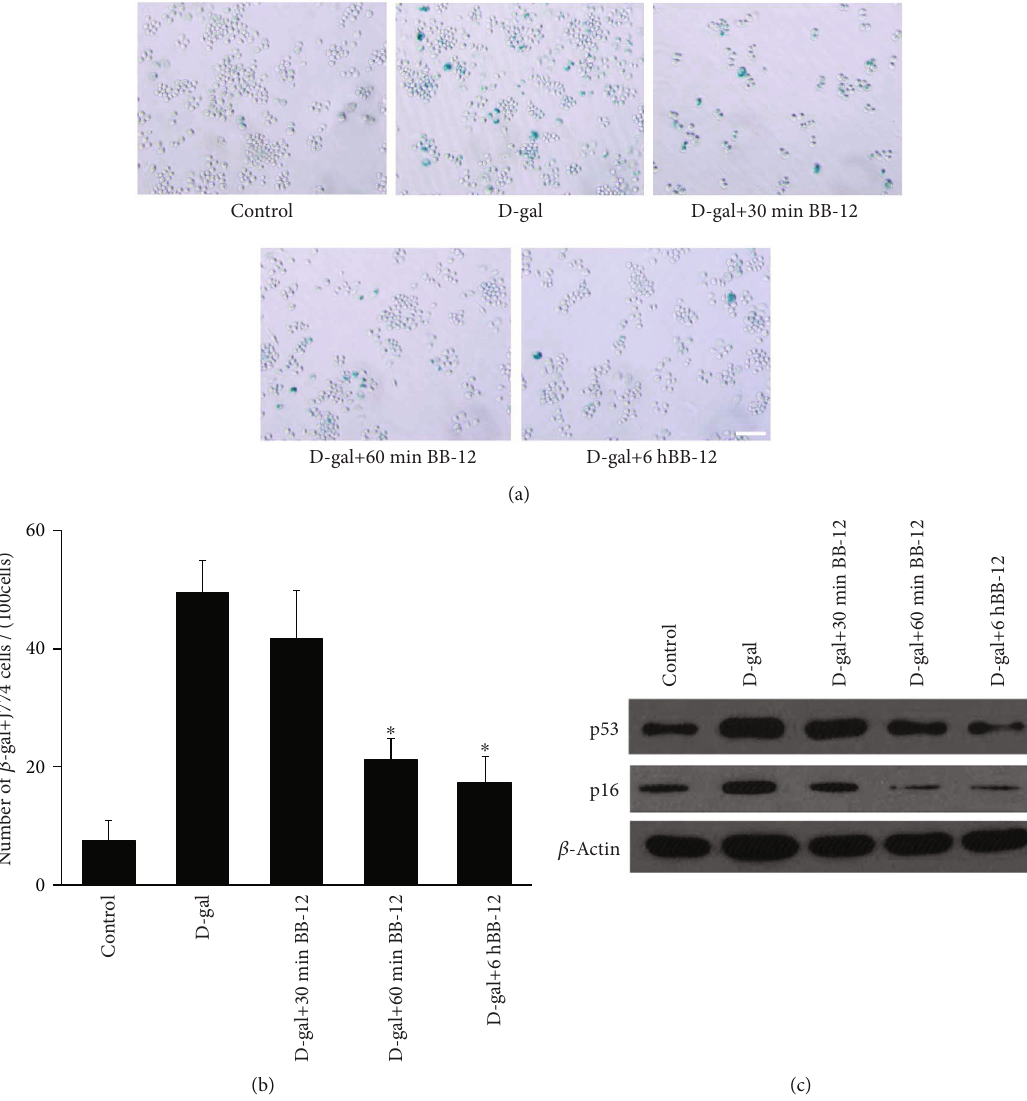
Figure 5: E ff ects of BB-12 on J774A.1 macrophage senescence. (a) SA- β -gal staining. Compared with the D-gal group, the SA- β -gal-positive cells in the BB-12 group signi fi cantly decreased. (b) SA- β -gal-positive cell quanti fi cation. The counts showed that the number of SA- β -gal- positive cells in the D-gal+60min BB-12 and D-gal+6h BB-12 groups decreased signi fi cantly compared with that in the D-gal group ( ∗ P < 0 : 01 , n = 5 ). (c) Western blot analysis of the p53 and p16 expression levels. The p53 and p16 expression levels were gradually lower in the D-gal+30min BB-12, D-gal+60min BB-12, and D-gal+6h BB-12 groups compared with those in the D-gal group. β -Actin was used as the internal